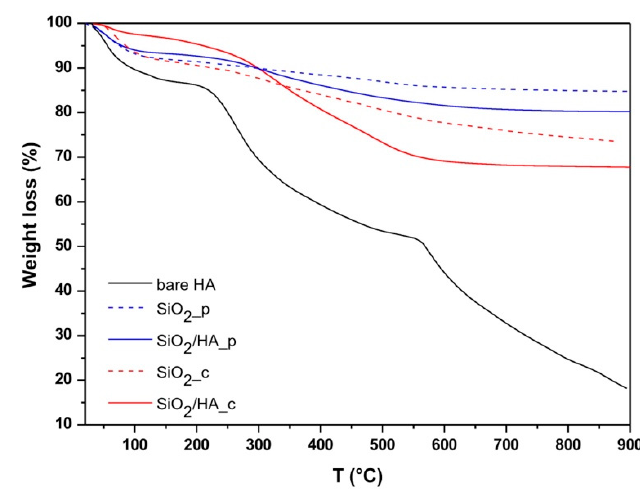
Figure 5. Thermogravimetric curves of pure HA, silica NPs and SiO 2 / HA hybrid NPs.